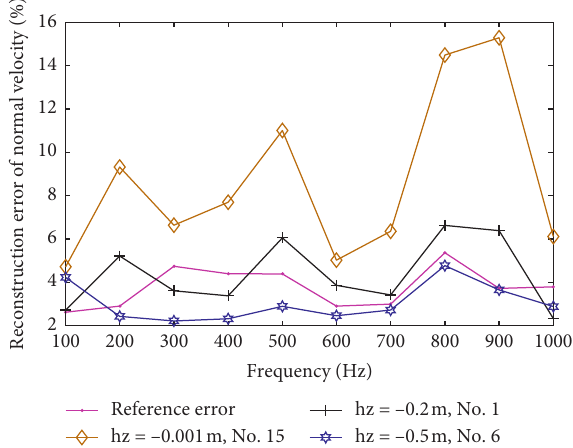
Figure 4: The reconstruction error of normal velocity versus the